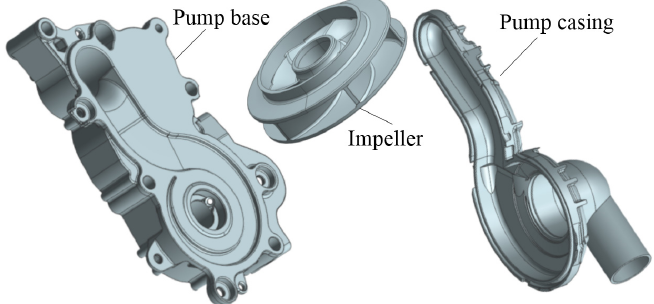
Figure 1. Three-dimensional structure of high-speed centrifugal pump model.